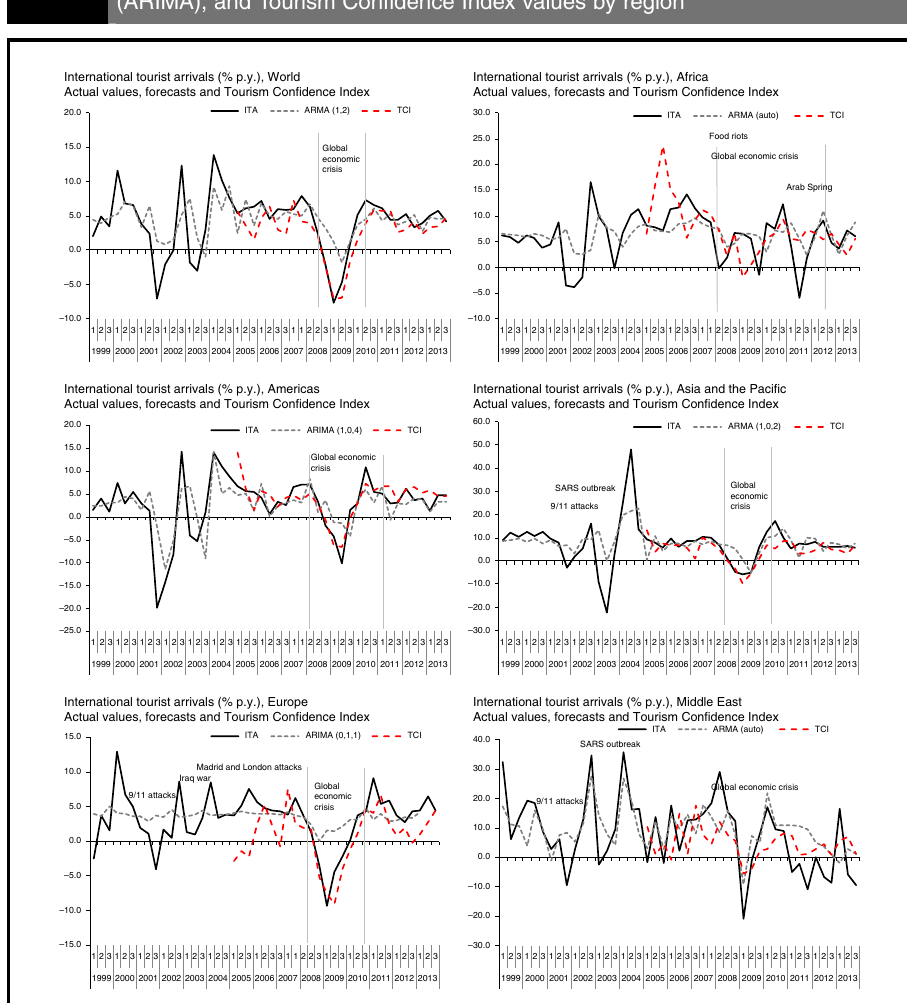
Figure 1 International tourist arrivals, actual (ITA, per cent p.y.) and forecast values (ARIMA), and Tourism Confidence Index values by